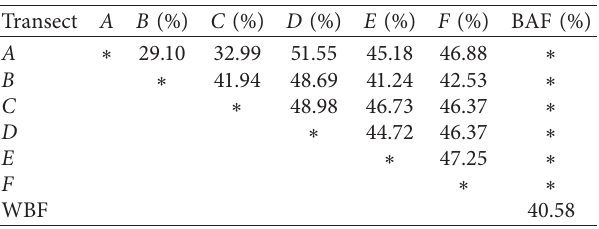
Source: computed from vegetation survey data, 2017.